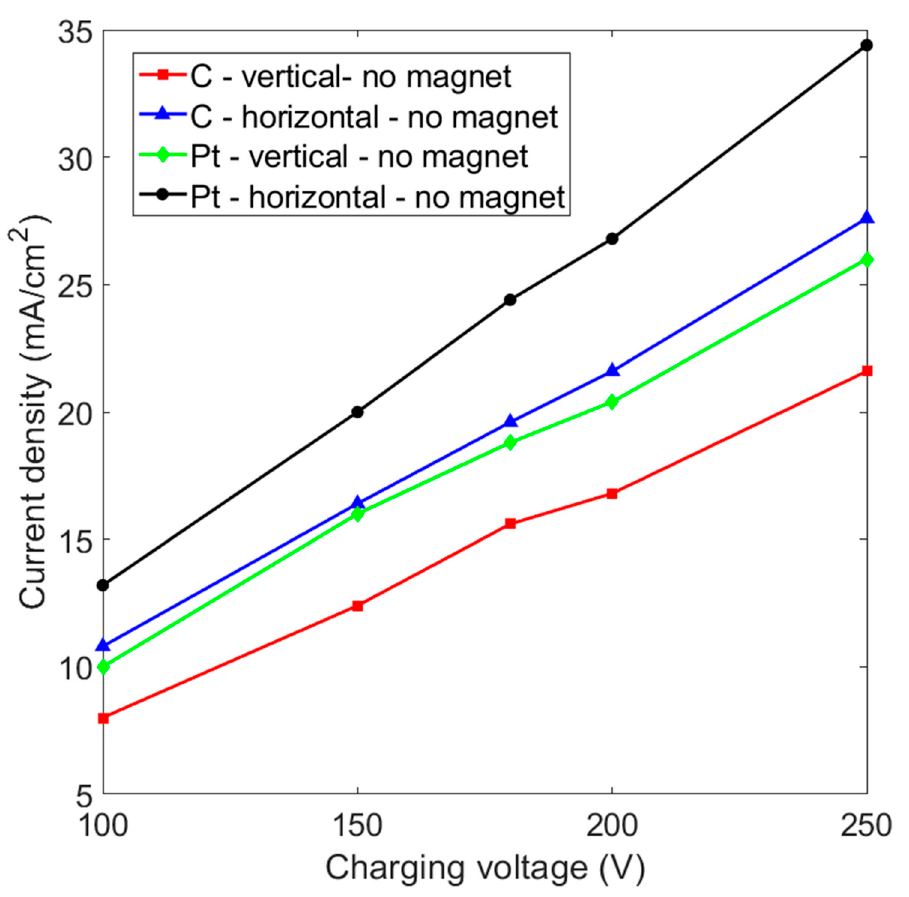
Figure 2. Current density vs. charging voltage for graphite (C) and platinum (Pt) electrodes that are placed in a vertical and horizontal layout without a magnet: the inter-electrode distance is 5 cm.